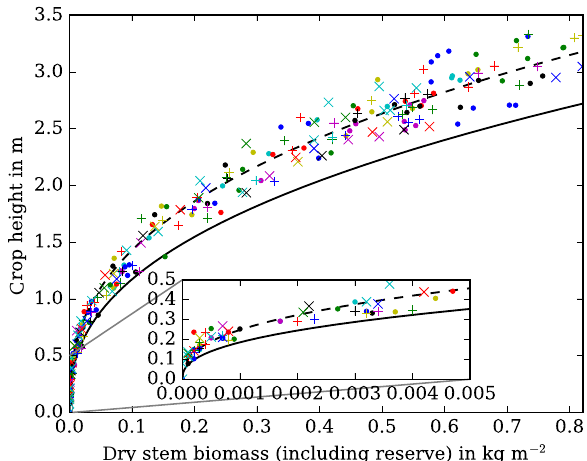
Figure 7. Carbon to biomass ratio in leaves against day after sow- ing. Dots, vertical crosses (+) and diagonal crosses (x) are US-Ne1, US-Ne2 and US-Ne3 observations respectively. The years 2001– 2004 are magenta, blue, cyan and yellow. Solid black line shows the value used in Osborne et al. (2015), dashed black line shows the value used in this analysis.